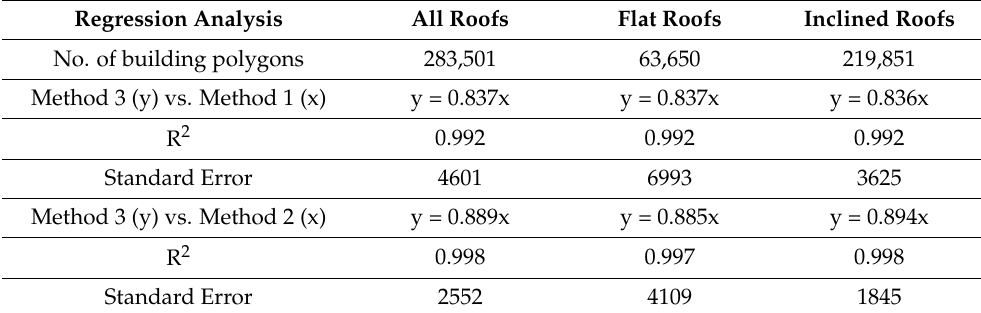
Table 6. Parameters of the regression analysis of solar power potential for each building estimated by different methods.